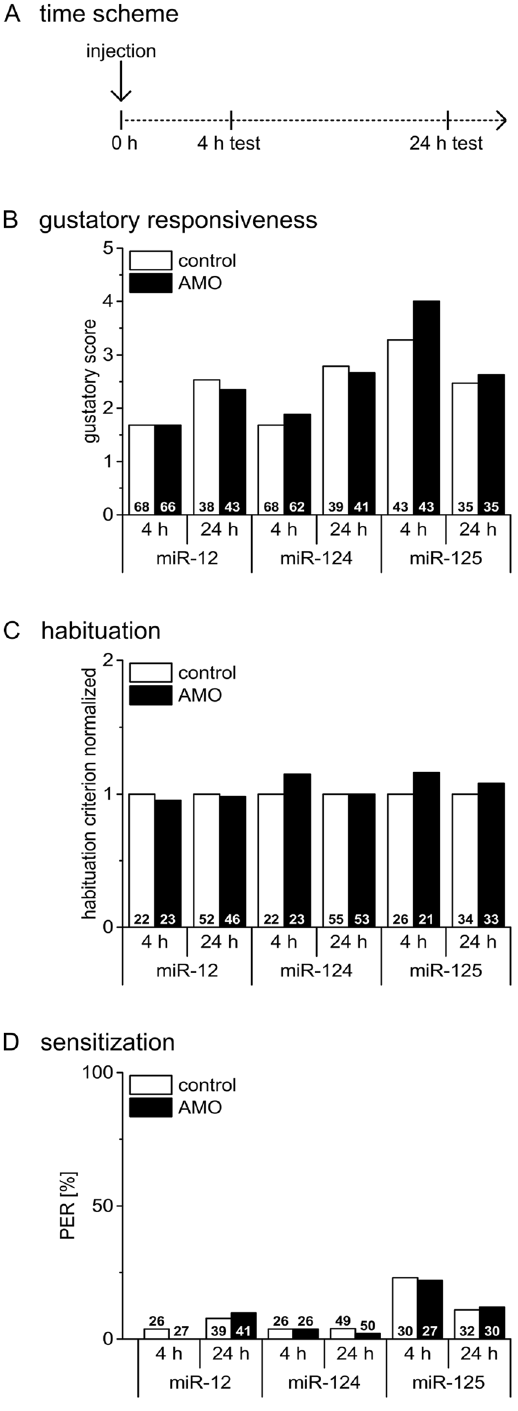
Figure 1. Inhihition of miRNAs neither affect gustatory sensitivity nor non-associative learning. ( A ) Four hours or 24 h after injection (miRNA inhibitors (AMO) for miR-12, miR-124 and miR-125 or the corresponding control) gustatory responsiveness, habituation and sensitization were tested. ( B ) The gustatory response scores do not differ between AMO- injected groups and their corresponding control (Mann-Whitney test; all p values > 0.3). ( C ) The habituation criterion of AMO injected groups do not differ from their corresponding control groups (Student’s t-test, all p values > 0.4). Habituation criteria were normalized to their corresponding control, each. ( D ) Sensitization as presented by the percentage of animals that show a PER after the sensitizing stimulus do not differ between the AMO-injected group and their corresponding control groups (Chi-square/ Fisher exact test, all p values > 0.4). The numbers of bees tested in the different groups are indicated in each